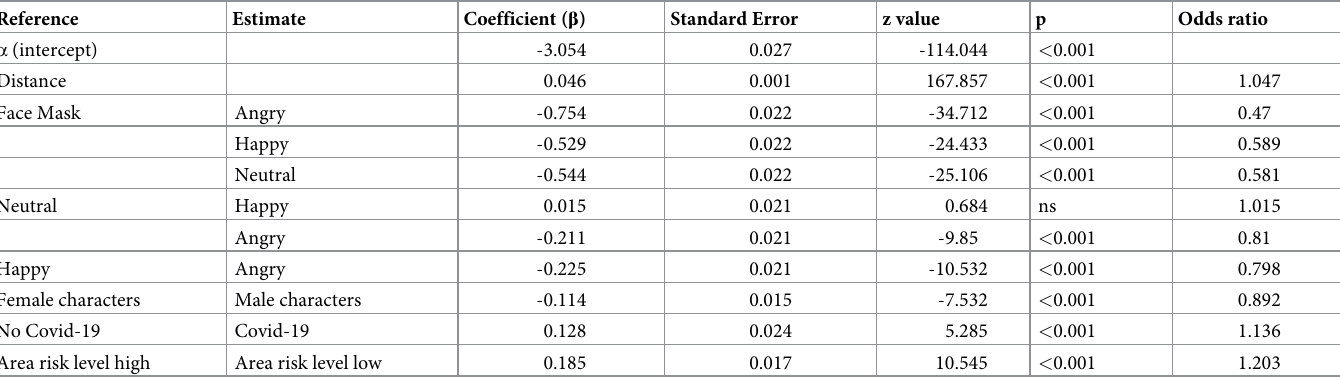
Table 1. Coefficients of the logistic regressions for the different